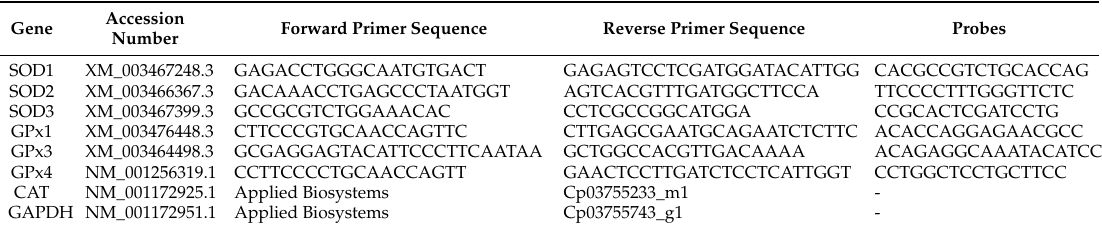
Table 1. Taqman Assay Primers and